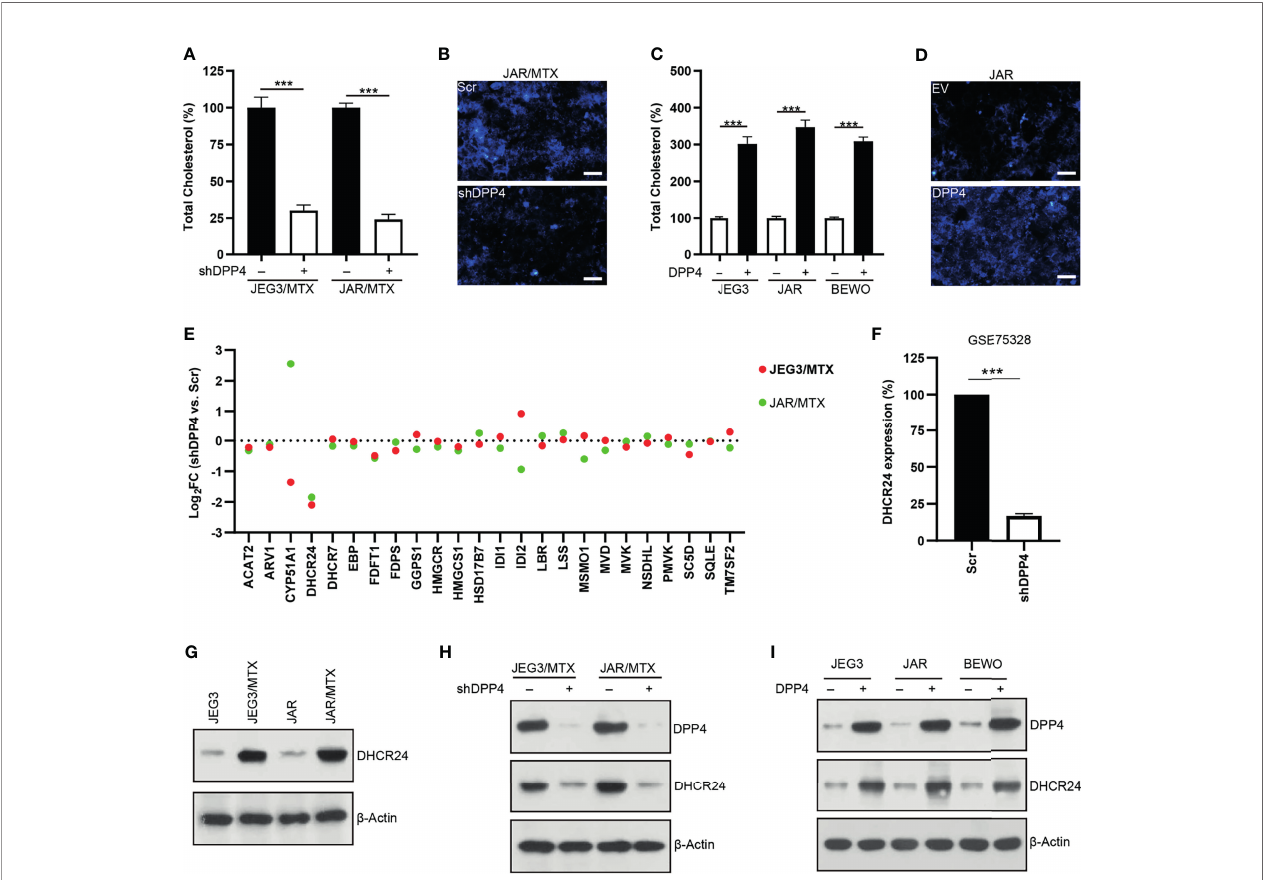
FIGURE 2 | DPP4 might regulate cholesterol biosynthesis through up-regulating DHCR24 expression in GTN cells. (A) Knockdown of DPP4 reduced the level of cellular cholesterol in JAR/MTX and JEG3/MTX cells. n=4, ***P<0.001. (B) Knockdown of DPP4 reduced Filipin-cholesterol fl uorescence in JAR/MTX cells. Bars: 50 m m. (C) Over-expression of DPP4 increased cellular cholesterol level in JAR, JEG3 and BEWO cells. n=4, ***P<0.001. (D) Overexpression of DPP4 increased Filipin- cholesterol fl uorescence in JAR cells. Bars: 50 m m. (E) Altered expression of cholesterol biosynthesis-related enzymes following DPP4 knockdown in MTX-resistant GTN sublines. (F) Analysis on GSE75328 revealed dramatic decline of DHCR24 expression following DPP4 knockdown in primary human preadipocytes. n=4, ***P<0.001. (G) Expression of DHCR24 in parental GTN cells and their MTX-resistant sublines. (H) Knockdown of DPP4 reduced the expression of DHCR24 in JAR/ MTX and JEG3/MTX cells. (I) Over-expression of DPP4 increased DHCR24 expression in JAR, JEG3 and BEWO